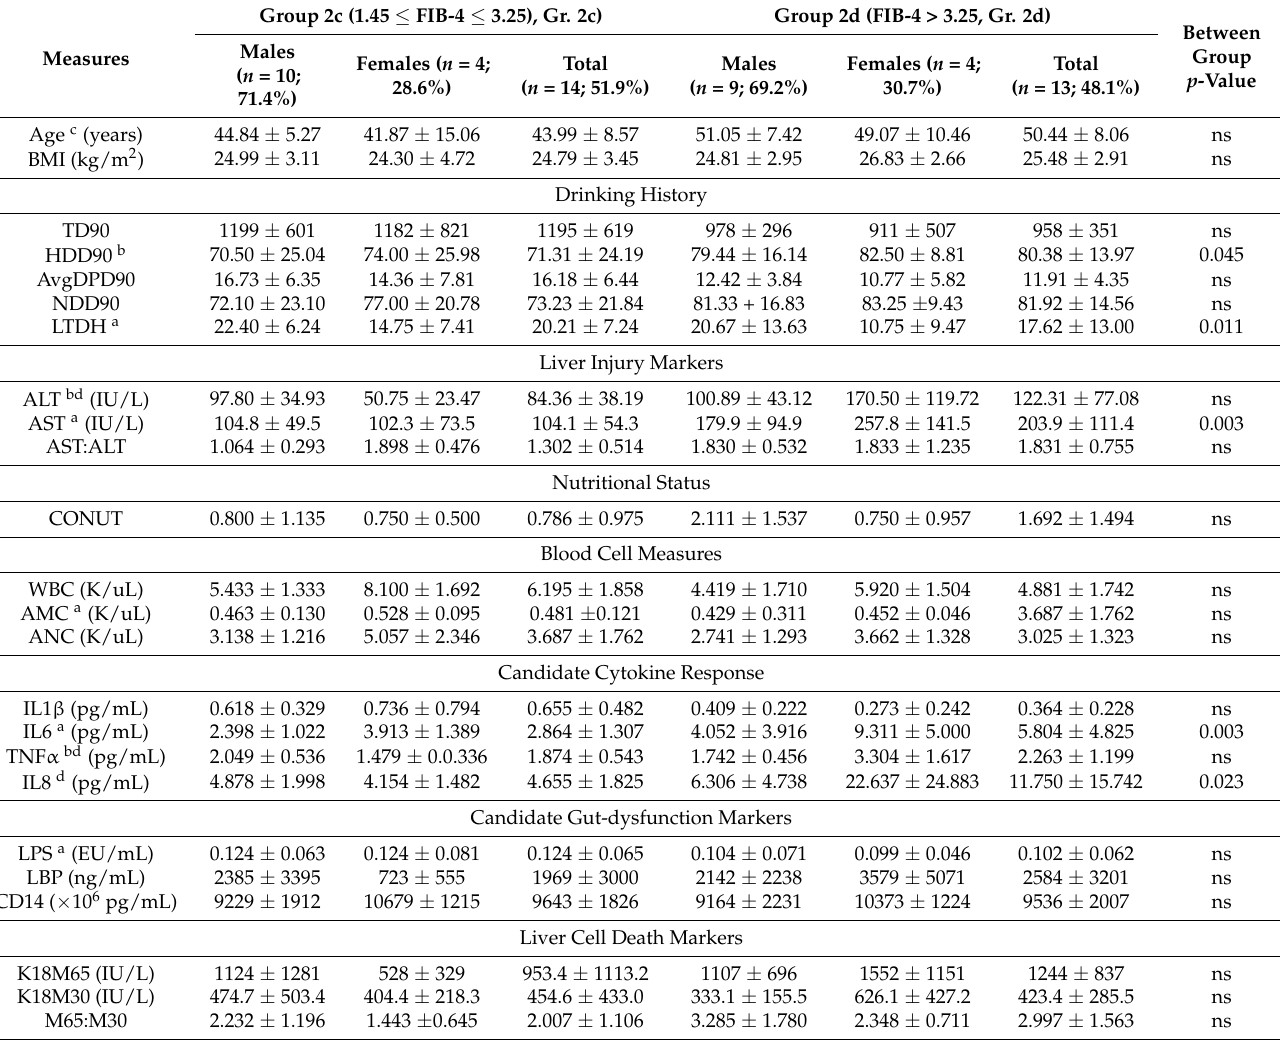
Table 2. Within elevated baseline FIB-4, tabulation by moderate and severe elevation of FIB-4 of: demographics, drinking history, baseline liver injury measures, baseline nutritional status, baseline candidate blood panel measures, baseline cytokines, baseline gut dysfunction markers, and baseline cell death markers of alcohol use disorder patients. Only markers that were significantly different in Table 1 are presented